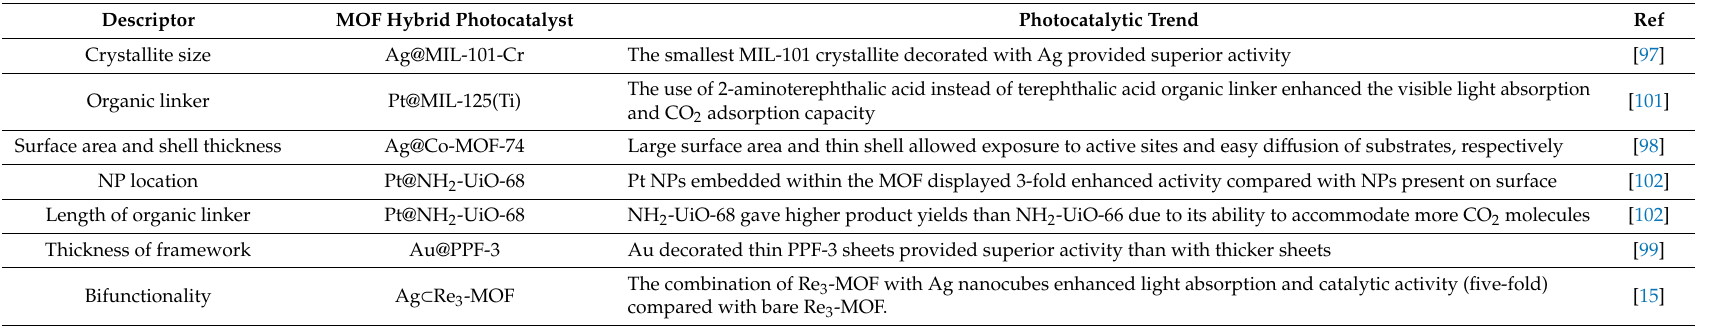
Table 3. Catalytic descriptors summarising noble metal species incorporated within MOFs for photocatalytic CO 2 utilisation.